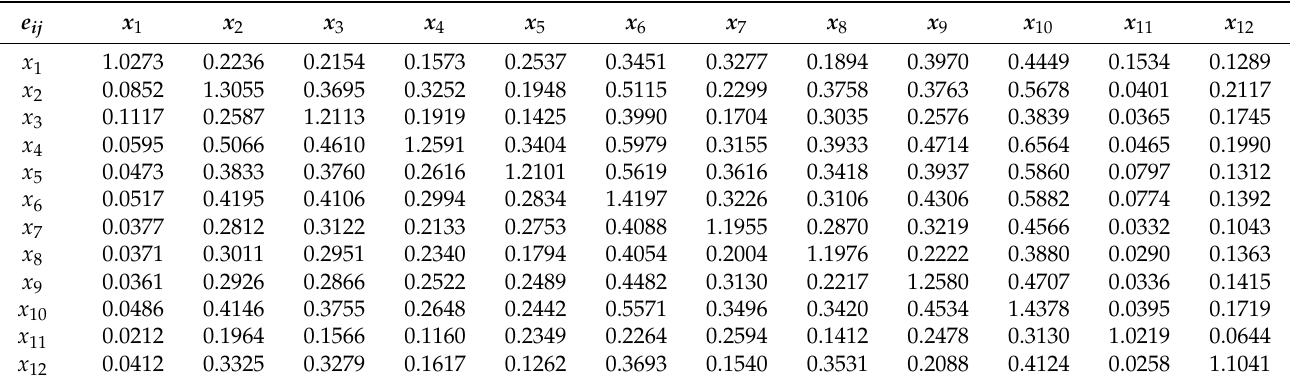
Table 5. Global impact matrix E